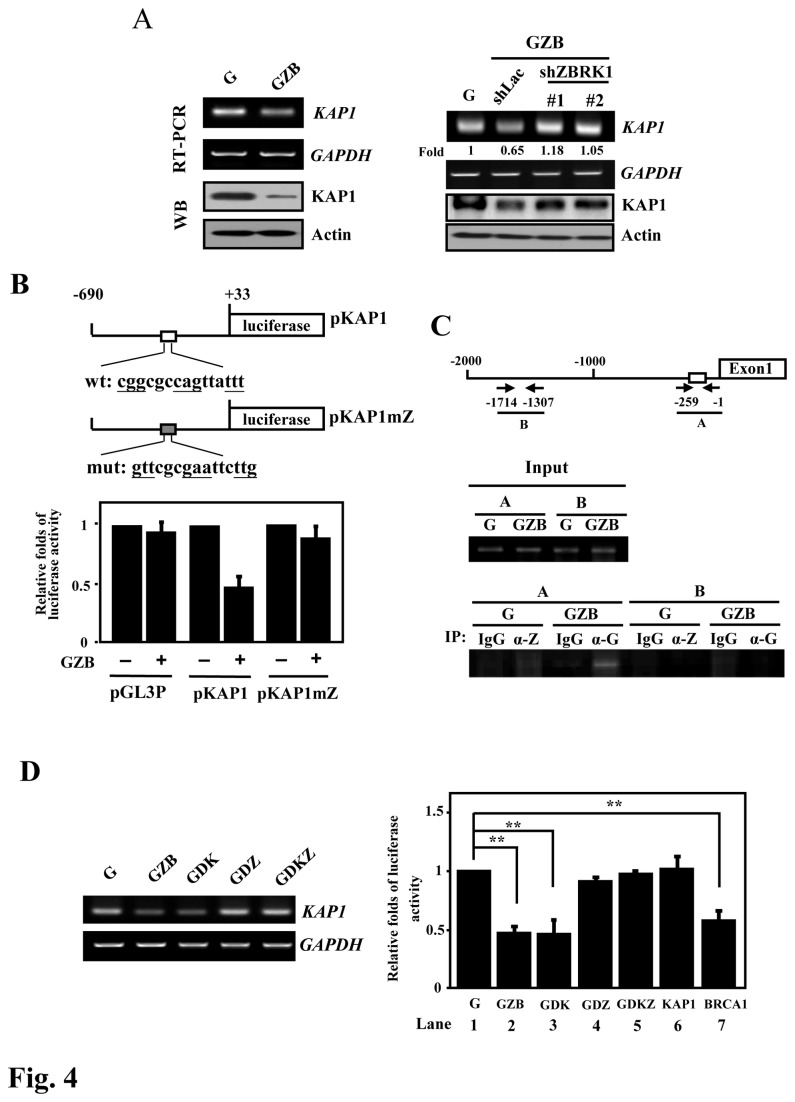
ZBRK1 represses KAP1 promoter activity.
A, Left, ZBRK1 inhibits KAP1 transcripts in HeLa cells. The total RNA and lysates of EGFP (G) and EGFP-ZBRK1 (GZB) HeLa cells were harvested for RT-PCR and Western blot analyses. Right, the loss-of-function ZBRK1 enhances KAP1 transcripts. Stable ZBRK1-expressing cells were incubated with lentiviral shRNA against ZBRK1 or the control. The total RNA of infected cells was analyzed using RT-PCR. Human GAPDH served as a control. B, ZBRK1 inhibits the KAP1 reporter. Top, schematic representation of the luciferase reporter constructs containing the KAP1 promoter with wild-type or mutant ZBRK1- binding motifs. The sequences of the wild type (wt) and mutant (mut) ZBRK1-binding motifs are shown. HeLa cells were co-transfected EGFP-ZBRK1 (GZB) with pGL3 promoter reporter (pGL3p), wild-type KAP1 or mutant ZBRK1 binding motif KAP1 reporters. Lysates of the transfectants were harvested after 12 h for the luciferase assay. The relative fold change in luciferase activity of the various KAP1 reporter constructs are shown after normalization to the wild-type KAP1 reporter. Bars, mean ± SD. C, ZBRK1 binds to the KAP1 promoter in vivo. The sheared formaldehyde cross-linked chromatins, extracted from HeLa cells stably expressing EGFP (G) or EGFP-ZBRK1 (GZB), were immunoprecipitated with the indicated antibodies: control IgG (gG), ZBRK1 (-Z) and GFP (-G). PCR amplification with specific primers targeting the KAP1 promoter was performed, as described in the Materials and Methods. The figure represents the PCR products obtained using primers specific for the KAP1 promoter region, as shown in the top panel. D, Left, the C-terminally deleted ZBRK1 mutant reverses the suppressive effect on KAP1 transcripts. The expression levels of KAP1 in HeLa cells exogenously expressing EGFP (G), EGFP-ZBRK1 (GZB), EGFP-ZBRK1 with KRAB domain deletion (GDK), EGFP-ZBRK1 with CTRD domain deletion (GDZ) or EGFP-ZBRK1 with both KRAB and CTRD deletion (GDKZ). A RT-PCR assay was conducted with specific primers of indicated genes. Right, BRCA1 is important for the ZBRK1-mediated inhibition of KAP1 reporter activity. HeLa cells were co-transfected with the KAP1 reporter and EGFP (G), GZB, GDK, GDZ, GDKZ, KAP1 or BRCA1 expression vectors. Lysates of the transfectants were harvested after 12 h of transfection for luciferase assay. The data shown are the mean ± SD.